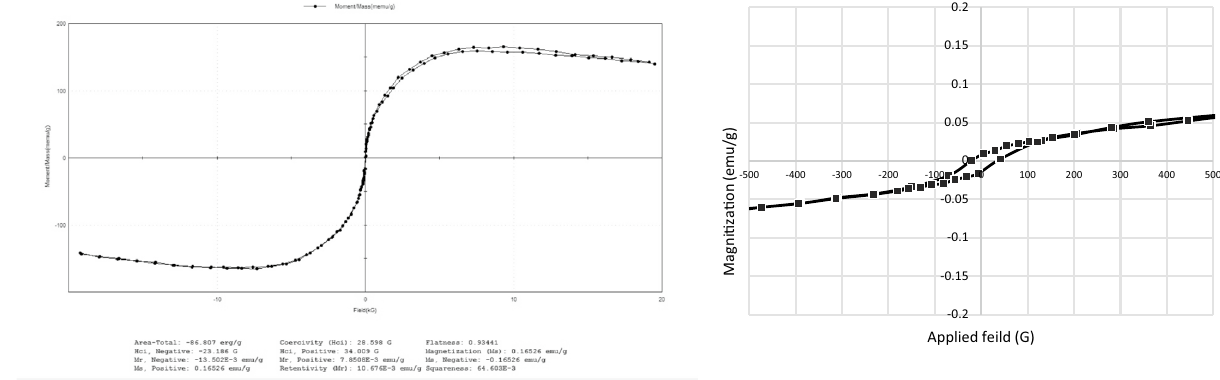
Figure 8. Magnetization curve of the biosynthesized iron nanoparticles showed the formation of a hysteresis loop.